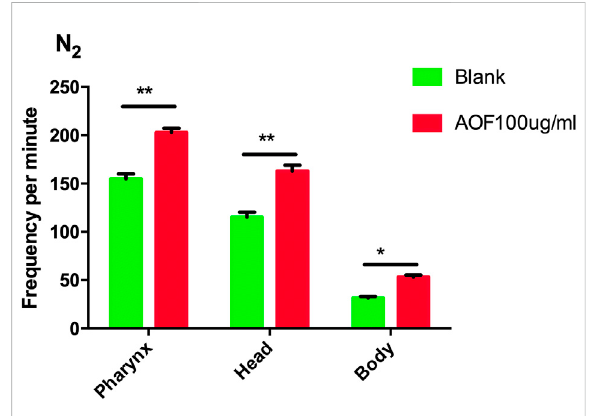
FIGURE 5 Effect of AOF treatment on the motility of wild-type